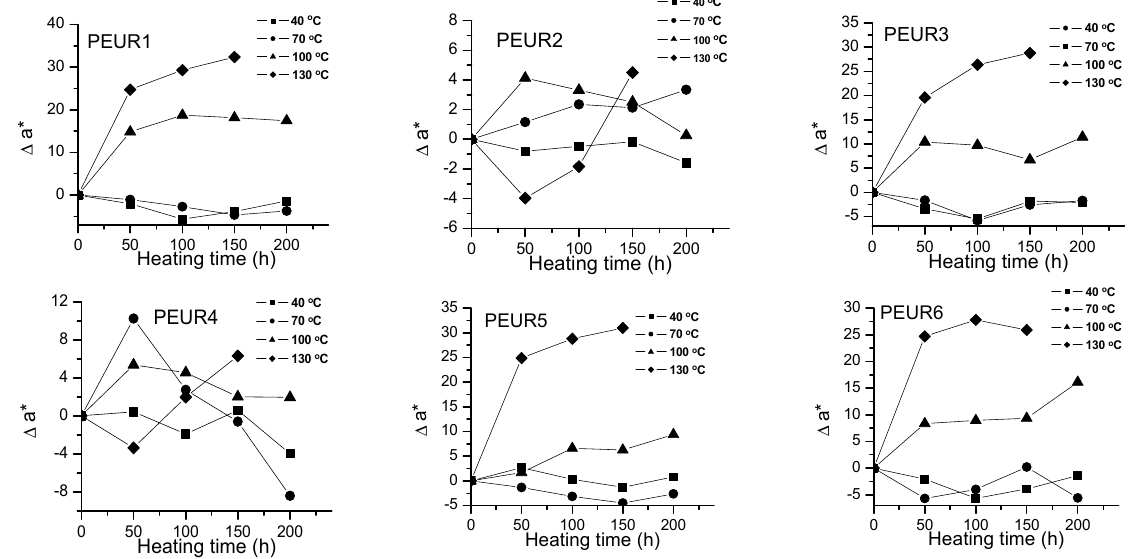
Figure 3. Variation of Δ a * with temperature and heating time of PEURs.